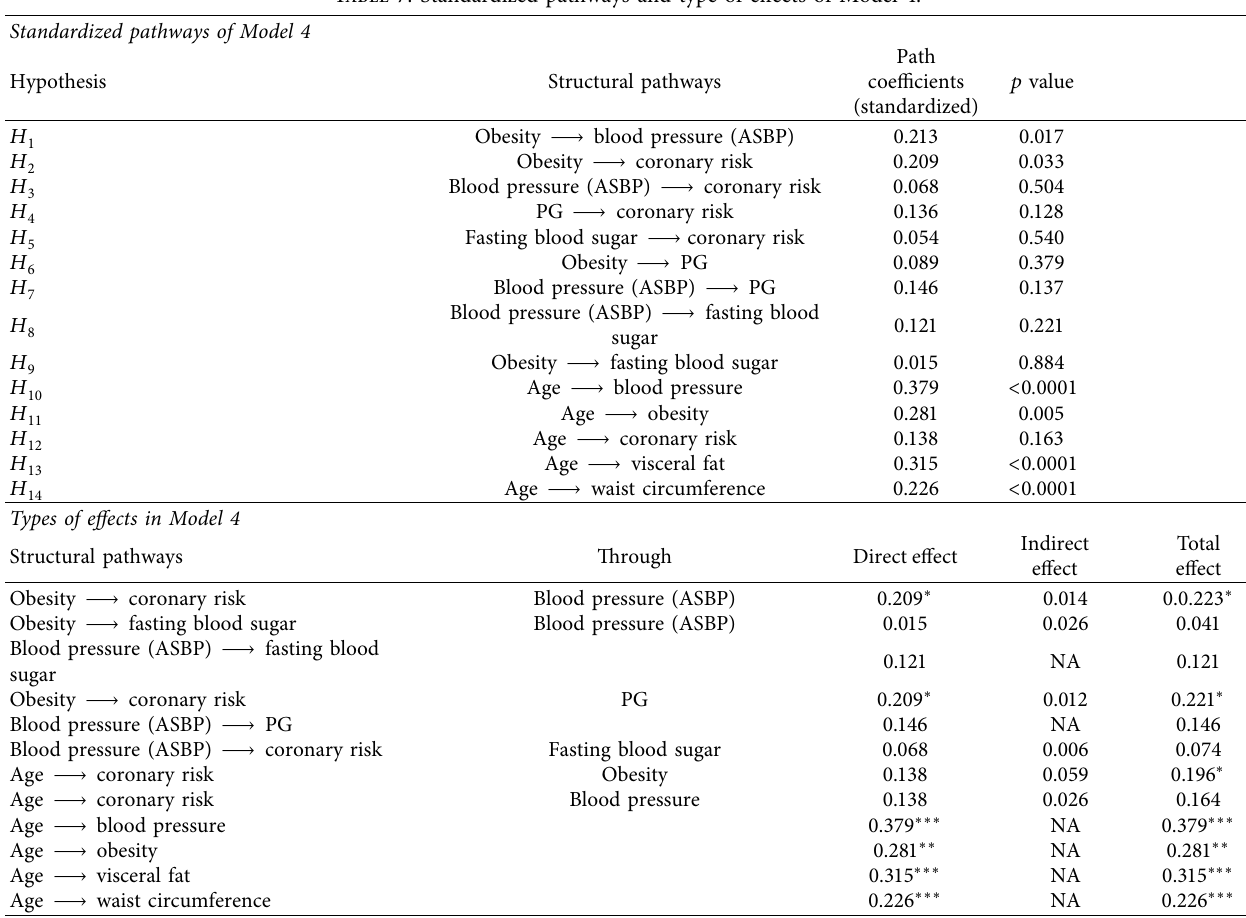
Table 7: Standardized pathways and type of effects of Model 4.